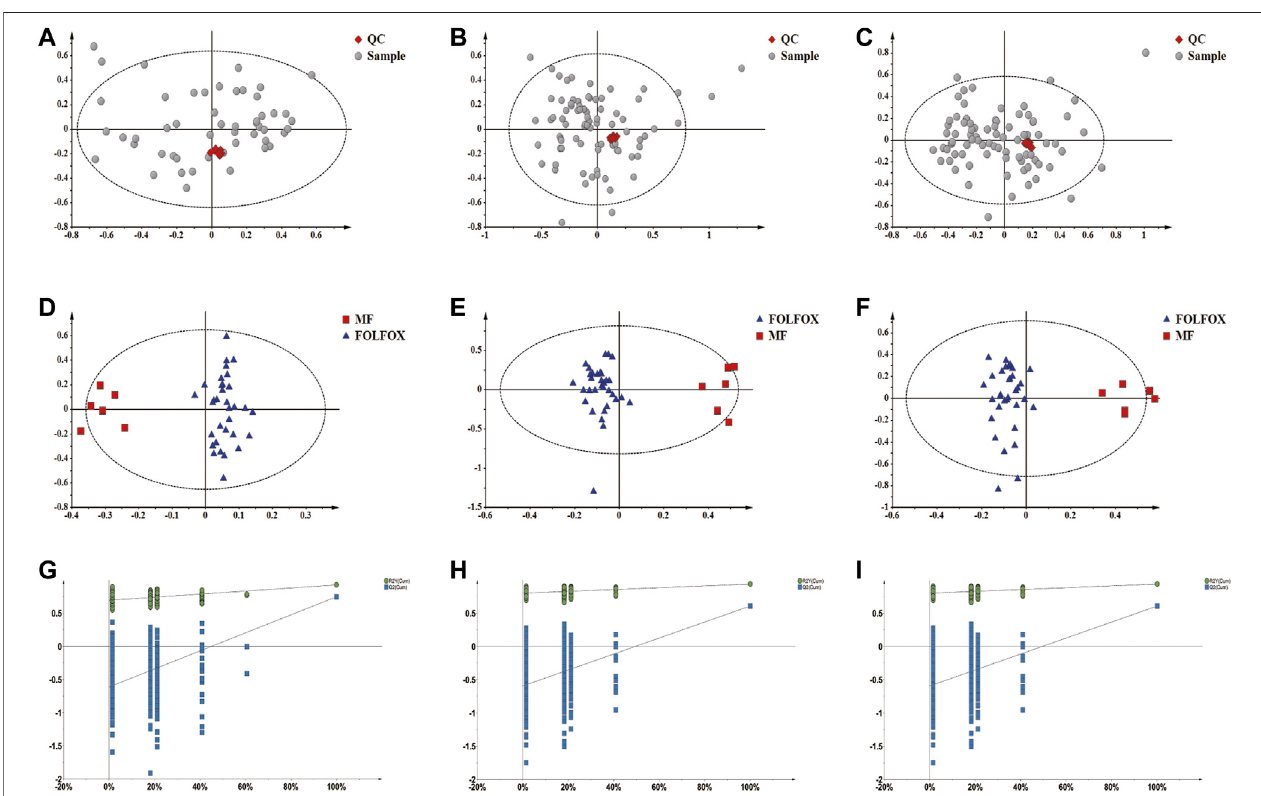
FIGURE 5 | Non-target metabolomics analysis of fecal samples from the MF and FOLFOX groups. (A – C) QCs clustered very well in the PCA score plots constructedbasedonGC-MS,LC-MS(+)andLC-MS( − )data. (D – F) OPLS-DAscoreplotsbasedonGC-MS(R 2 X:0.474;R 2 Y:0.929;Q 2 :0.66),LC-MS(+)(R 2 X:0.449; R 2 Y: 0.938; Q 2 : 0.607) and LC-MS ( − ) (R 2 X:0.342; R 2 Y: 0.925; Q 2 : 0.746) data, respectively. (G – I) Permutation test result (500 times) ofOPLS-DA models constructed from GC-MS, LC-MS (+) and LC-MS ( − ) data,